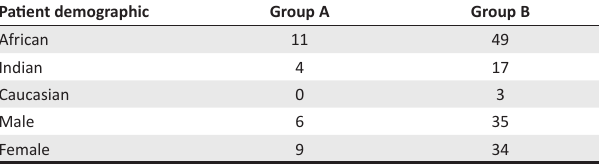
TABLE 2: Ethnic make-up of study sample.